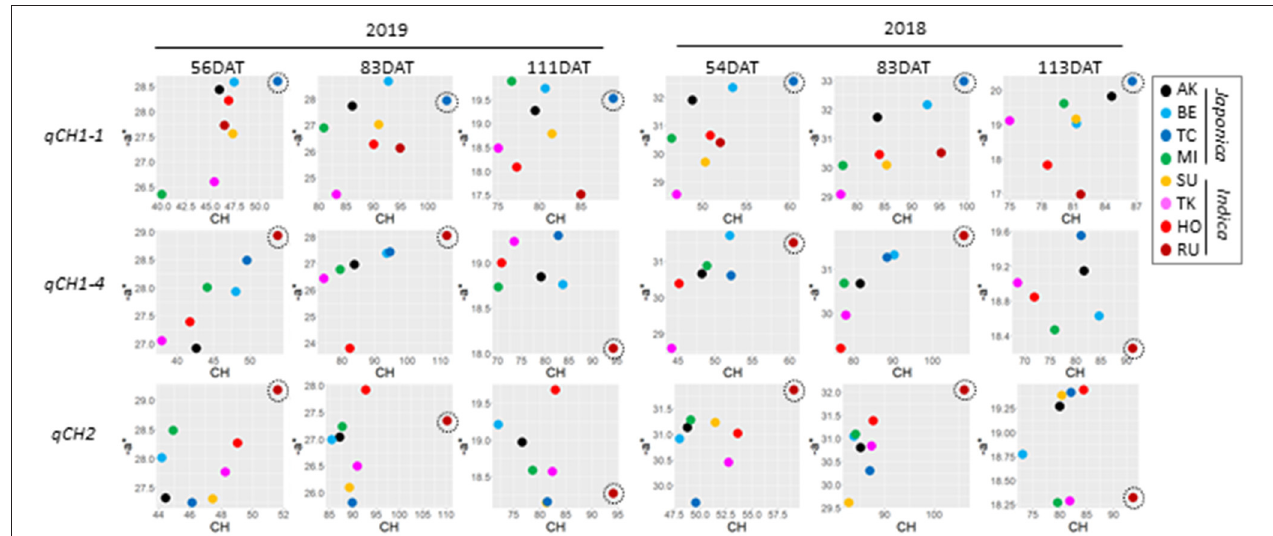
FIGURE 4 | Difference of the relationship between CH and –a* data at qCH QTLs. Plots of the correlation of haplotype effect between CH and –a* at qCH1-1 (top), qCH1-4 (middle) and qCH2 (bottom) in 2019 (left) and 2018 (right). Haplotype [TC] at qCH1-1 , haplotype [RU] at qCH1-4 , and haplotype [RU] at qCH2 were focused on as remarkable haplotypes for CH, and are indicated by dotted